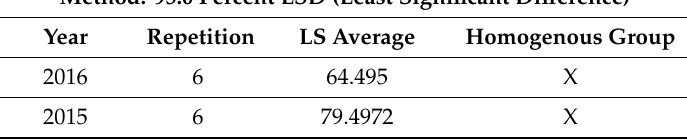
Figure 2 . Graphic representation of the 95% confidence intervals of the content of 19 monitored phenolic substances for the tested averages from individual variants in 2015 and 2016 for the Welschriesling variety . Table 10. Influence of the year on the total content of 19 monitored phenolic substances in wine in 2015 and 2016 for the RIE varieties.